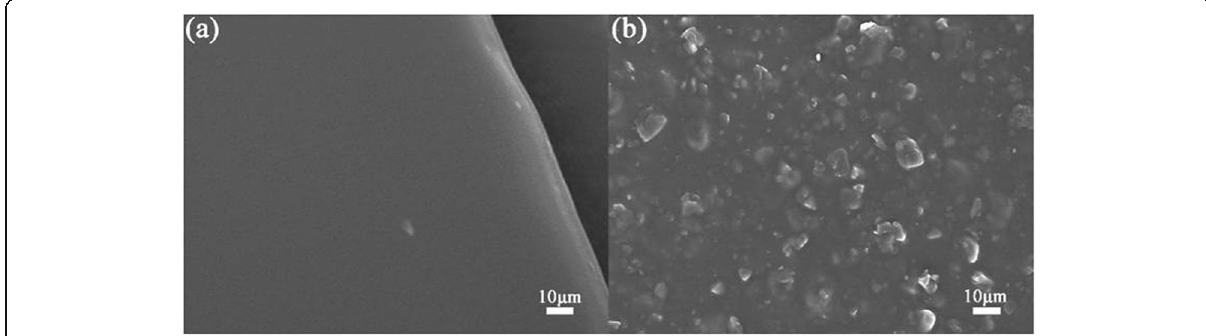
Fig. 2 SEM images of pure PVA film ( a ) and PVA/CNT film ( b